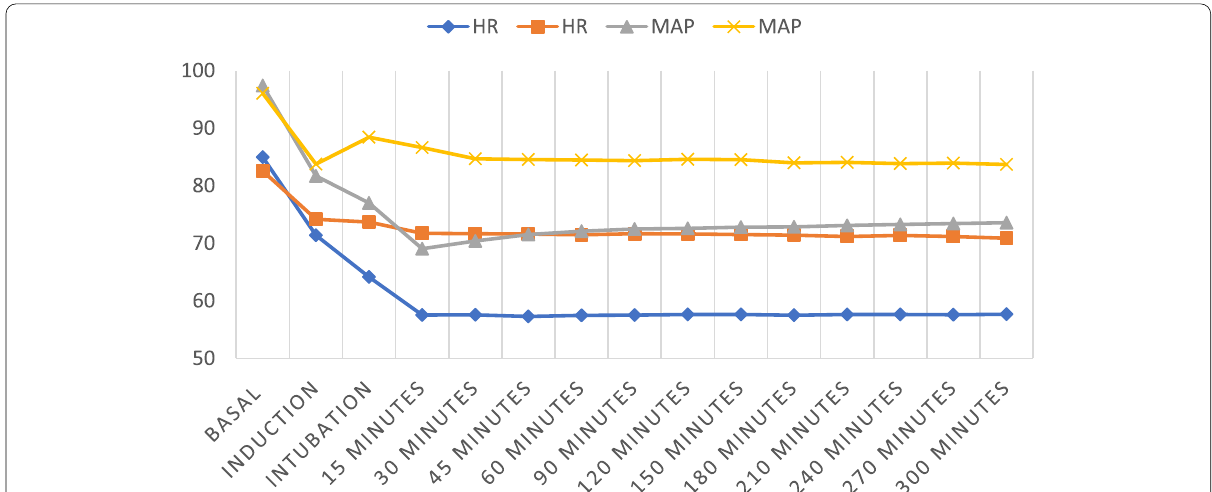
Fig. 1 Intra‑operative follow‑up of heart rate and mean arterial pressure of the studied groups